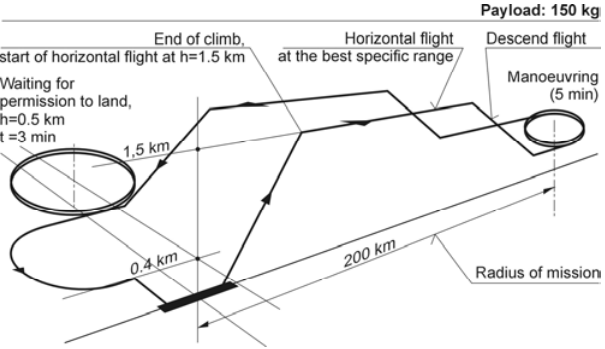
Fig 2. Typical mission of PW-124